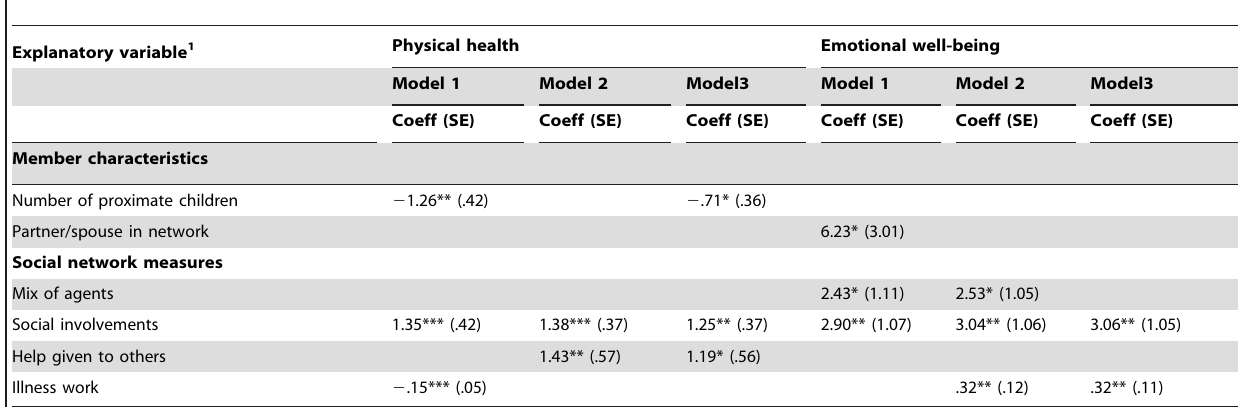
Table 4. Summary of regression analyses of outcomes at Time 1: Health status outcomes.